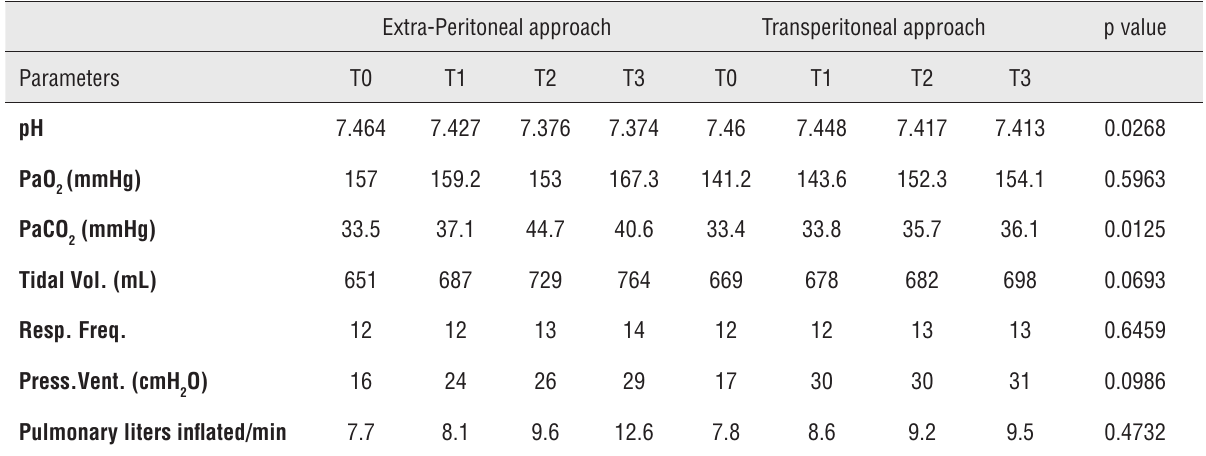
Table 3 - Gas exchange parameters. Extra-Peritoneal approach Transperitoneal